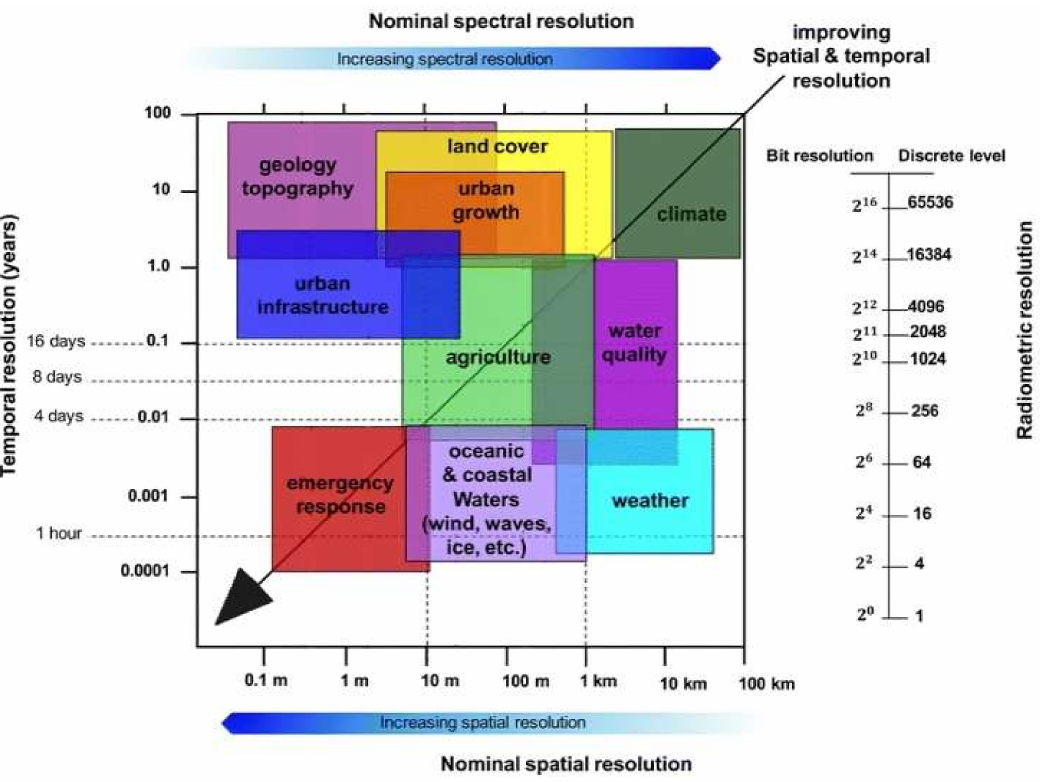
Figure 2. Resolution requirements for specific applications, adapted from Kadhim et al.